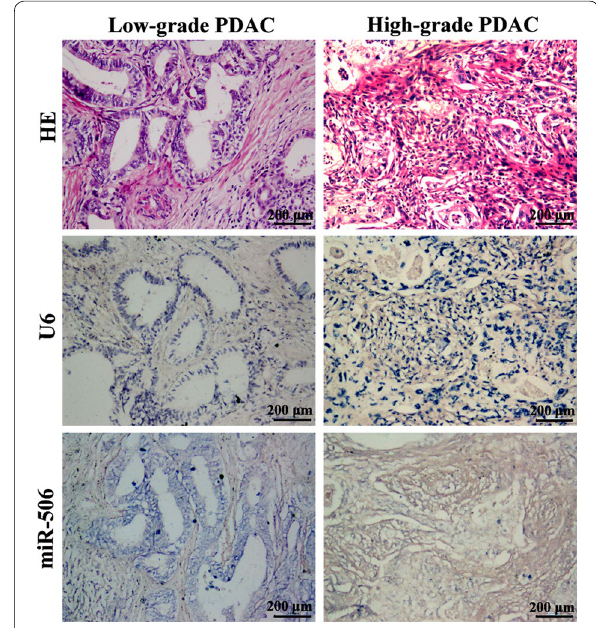
Fig. 3 The expression of miR‑506 in low‑grade (well and moderately differentiated) and high‑grade (poorly differentiated) PDACs. miR‑506 expression is obviously higher in low‑grade PDACs than in high‑ grade